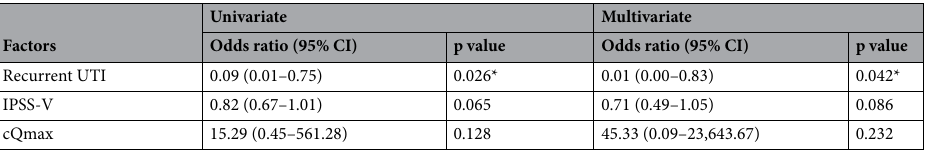
Table 3. Univariate and multivariate logistic regression analysis for the predictive factors of successful outcomes of PFMT. UTI urinary tract infection, IPSS-V International Prostate Symptom Score voiding subscore, cQmax corrected maximum flow rate. *p value <